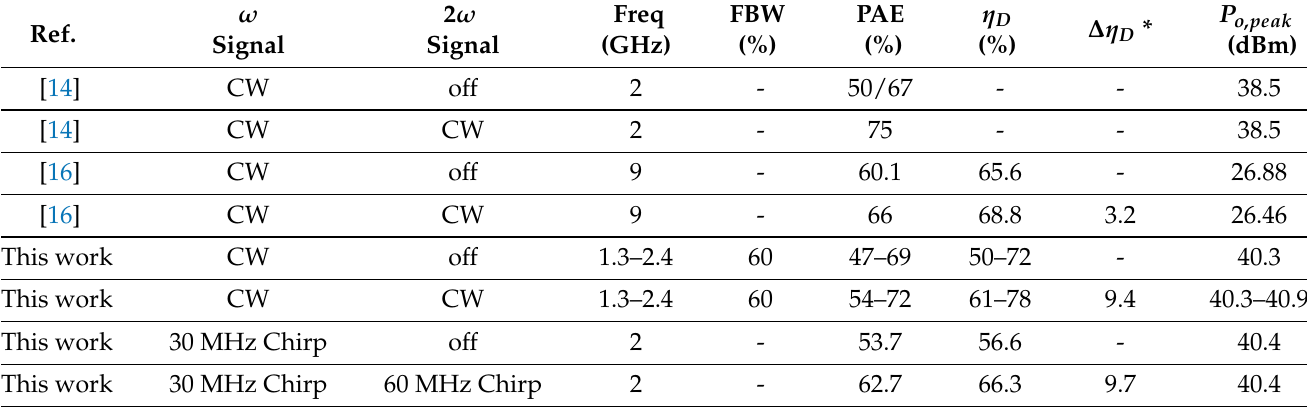
Table 1. Measurements with and without input second-harmonic